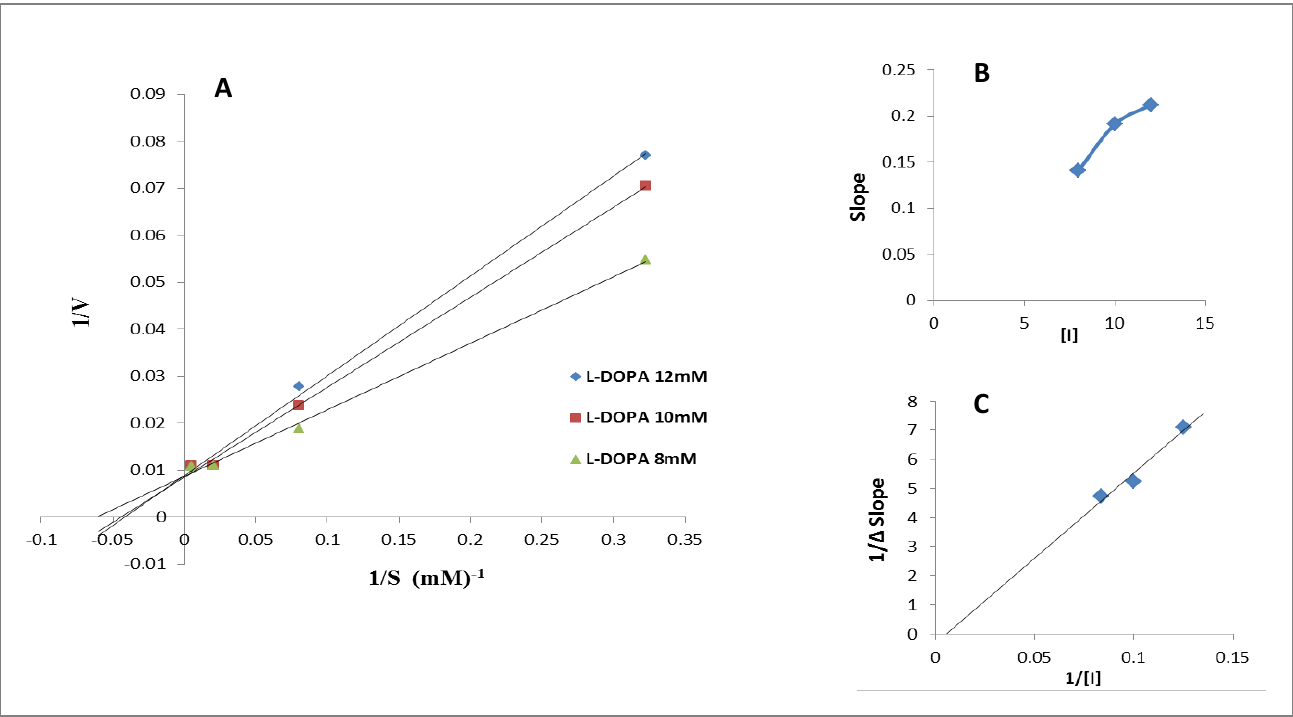
Figure 4: Kinetic properties of L. esculentum (var. Eva F1) (A) Lineweaver-Burk plot for the inhibition of var. Eva F1, (B) Re-plot of the slope of the Lineweaver-burk plot versus inhibitor concentration, (C) 1/ΔSlope versus 1/[I].